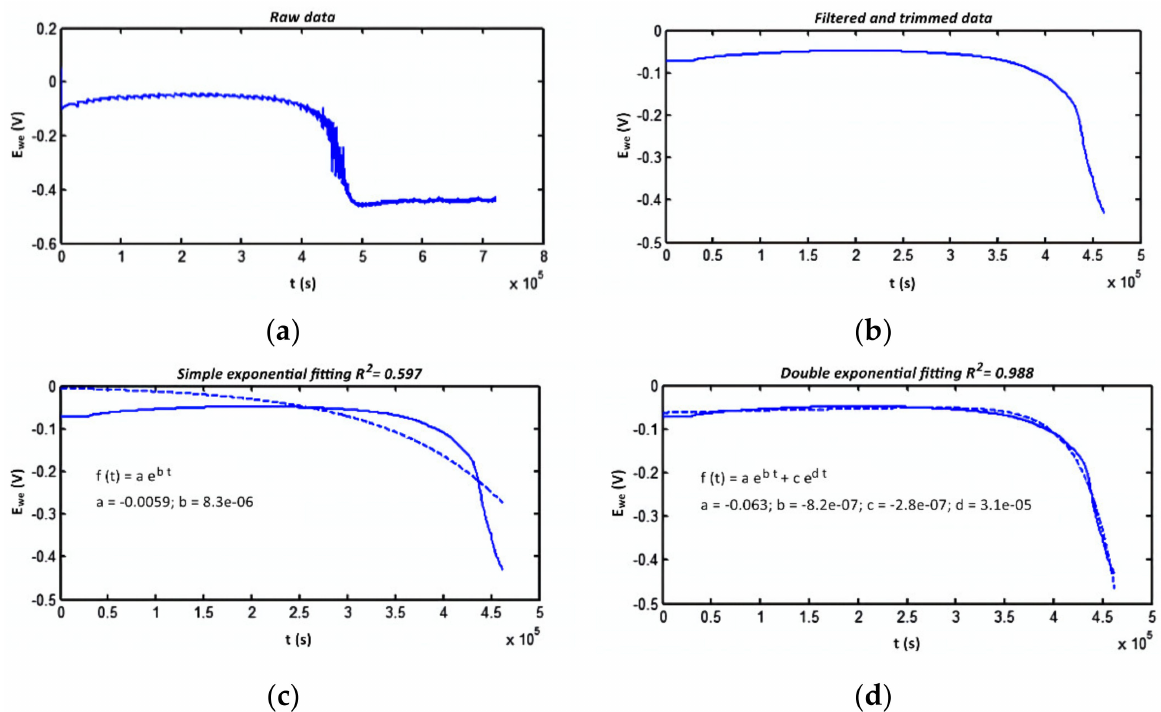
Figure 6. Comparison of experimental data with the model (R 2 is the coefficient of determination): ( a ) raw data; ( b ) data after processing; ( c ) primary exponential approximation; ( d ) double exponential